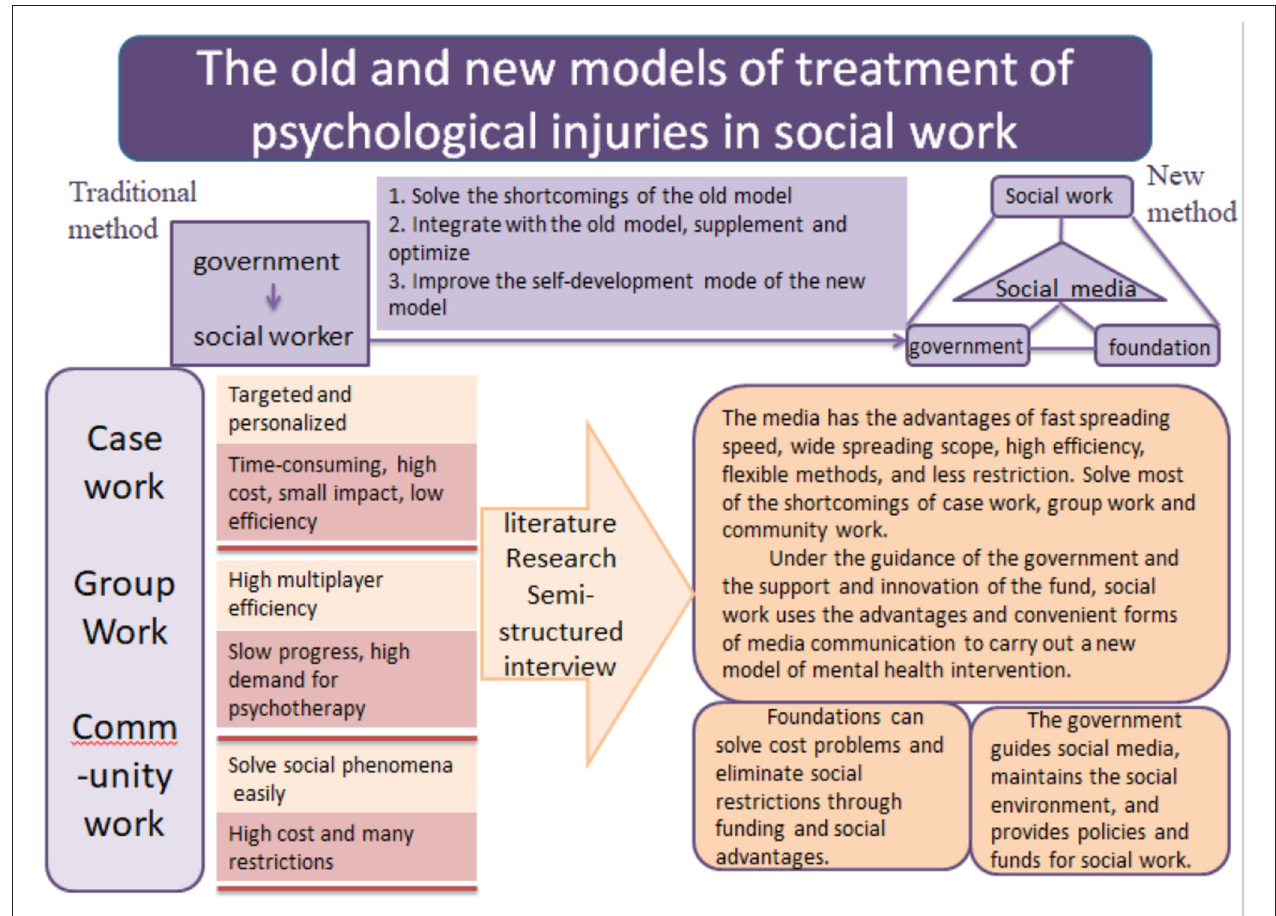
FIGURE 1 | The new mechanism of social work on psychological